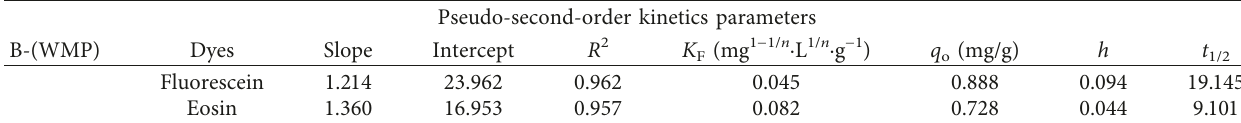
Table 9: Kinetic parameters of B-(WMP) sorbent.